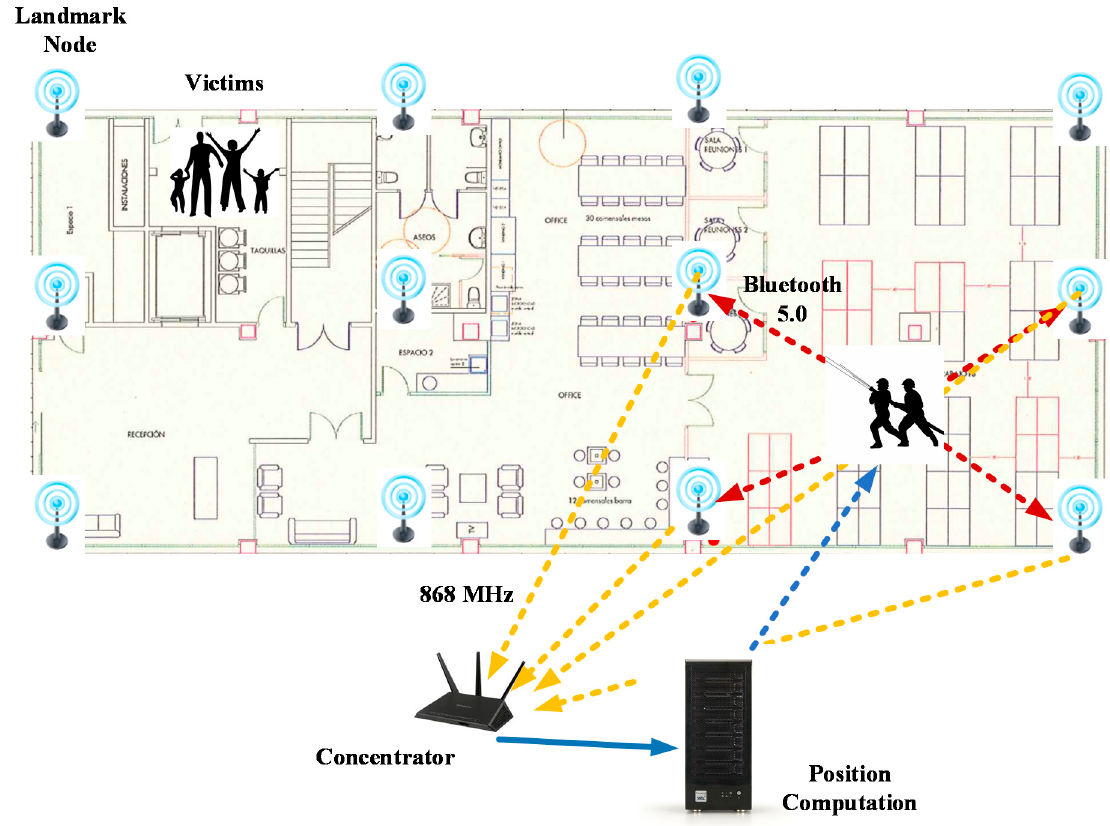
Figure 1. Map of the building with the landmark nodes in part of the building infrastructure. The concentrator and position computation system can be deployed on event to assist the rescue